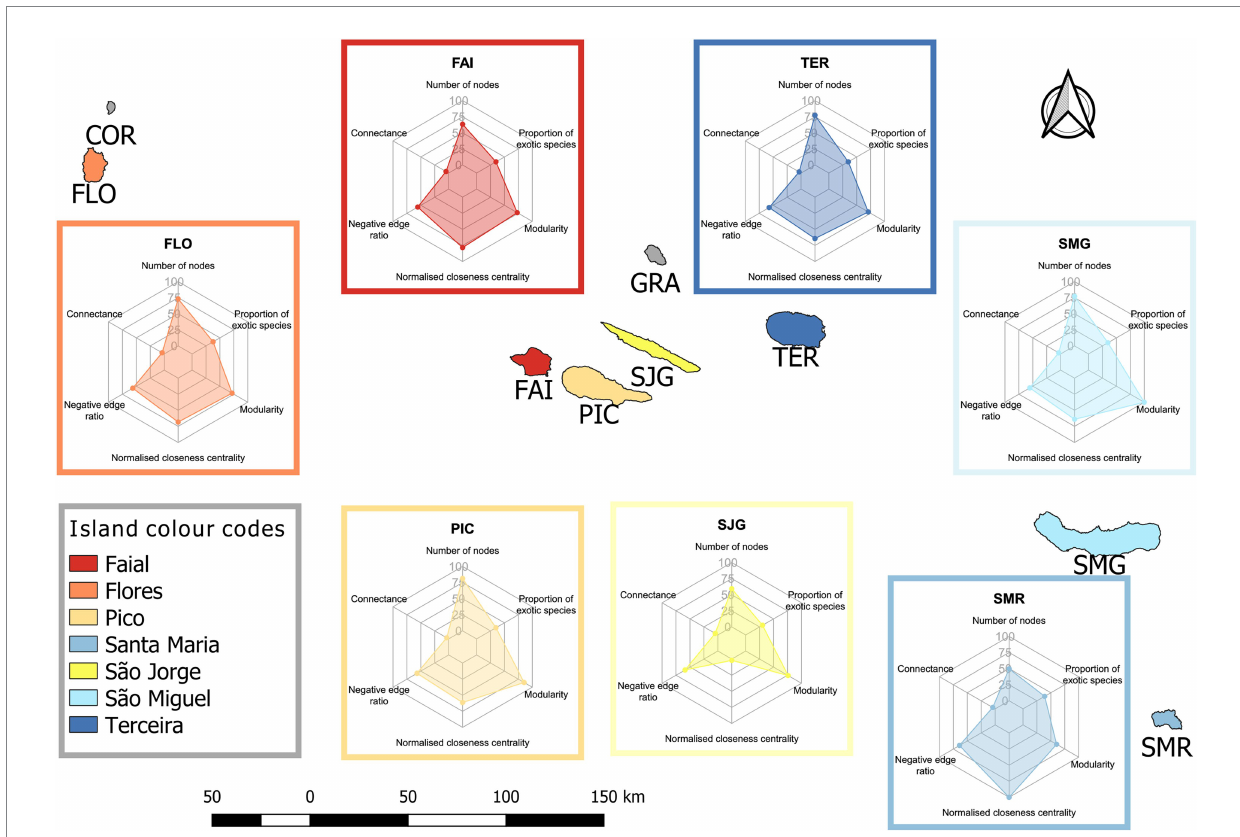
FIGURE 1 Map of the Azorean archipelago and the basic characteristics of the island co-occurrence networks. Islands are color coded and squares with borders of corresponding colors contain radar charts showing (clockwise from the top) (1) the percentage of island species richness to the species richness in the meta-network, (2) the percentage of exotic species to the island species richness, (3) the island modularity as a percentage of the maximum modularity of all islands, (4) the normalized closeness centrality of the island as a percentage of the maximum normalized closeness centrality of all islands, (5) the percentage of negative edges of all edges in an island, (6) connectance of a network. Island abbreviations: FAI – Faial, FLO – Flores, PIC – Pico, SJG – São Jorge, SMG – São Miguel, SMR – Santa Maria, TER –